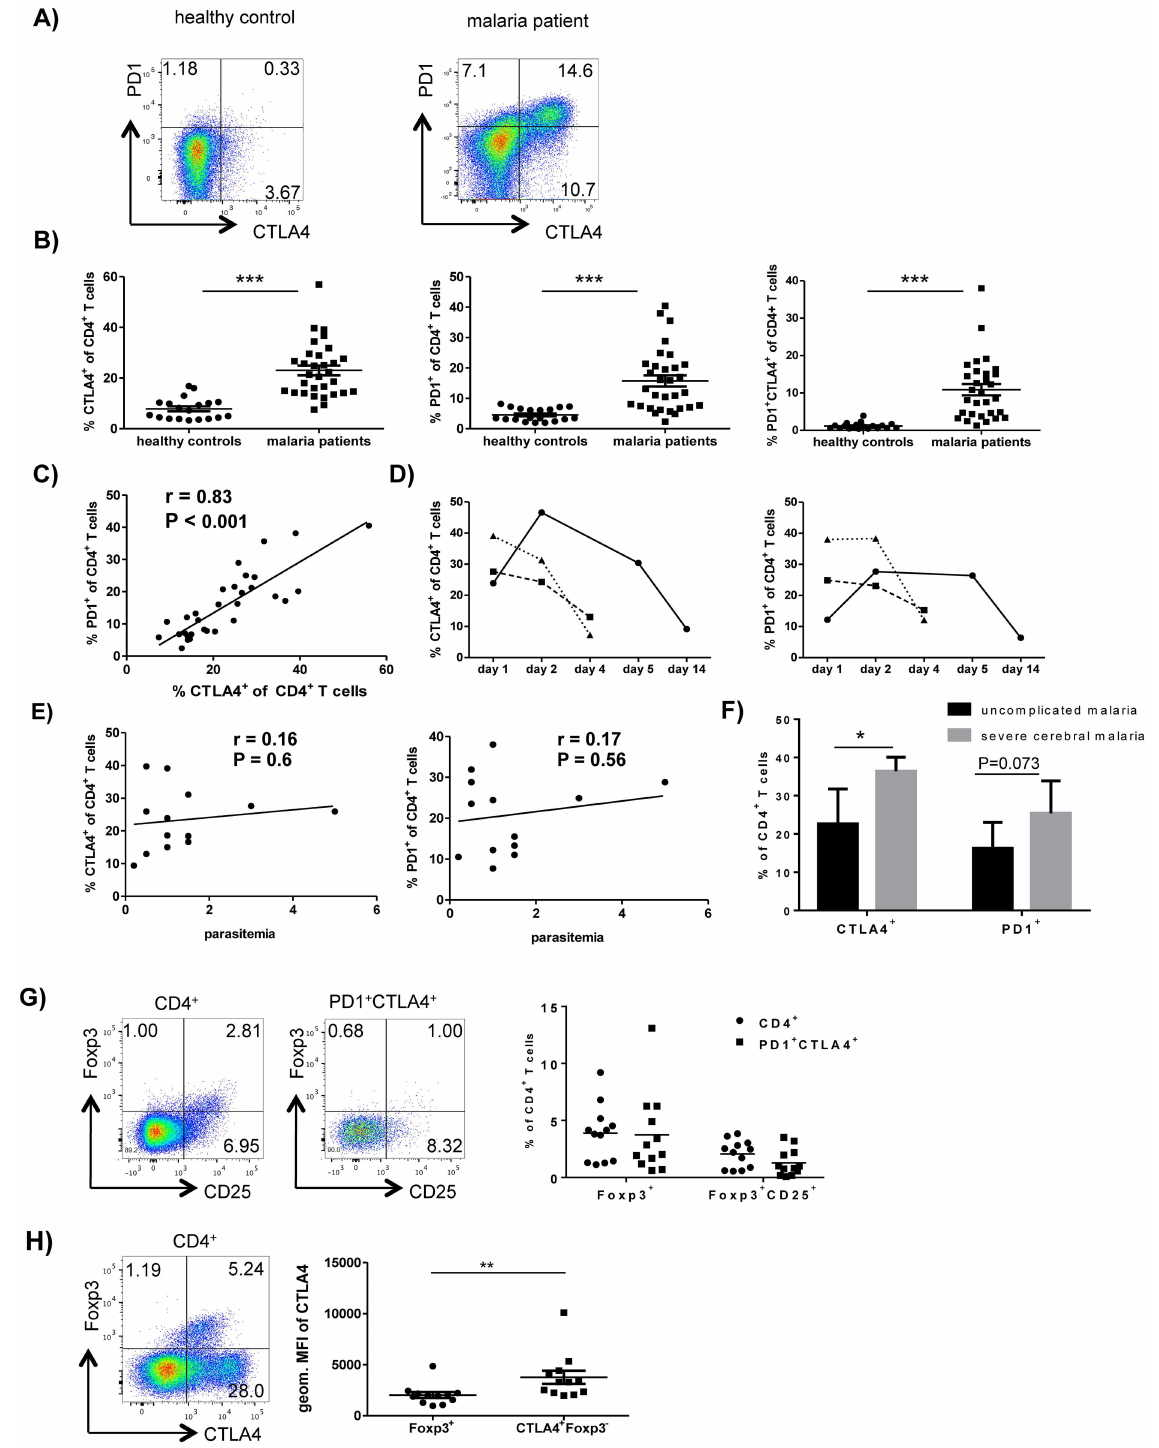
Fig 1. Acute P . falciparum malaria leads to a strong induction of CTLA4 and PD1 on conventional CD4 + T cells. A) Blood samples from acute malariapatients and healthy controls were analyzed ex-vivo for the expression of PD1 and intracellular CTLA4 on CD4 + T cells by flow cytometry. Dotplots show one representative donor out of 31 (malariapatients) or 19 (healthy controls). B) Scatter plots show the frequencyof CTLA4 + (left), PD1 + (middle) and PD1 + CTLA4 + cells (right) as percentage of CD4 + T cells for all analyzeddonors. Horizontalbars represent means. *** , P < 0,0001 (t-test with Holm-Sidakcorrection for multiple